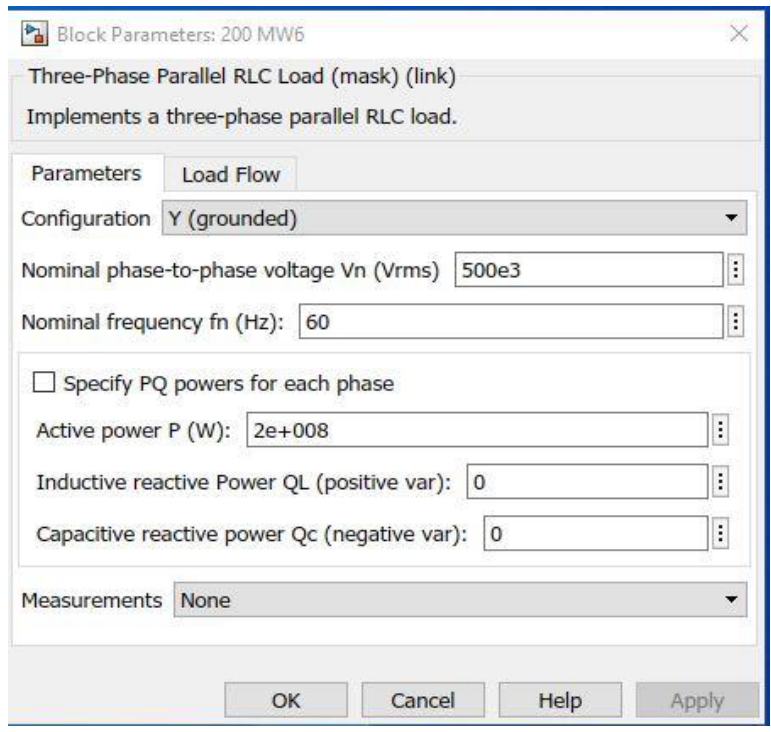
Figure 13. Parameters setting of 200 Load Block.